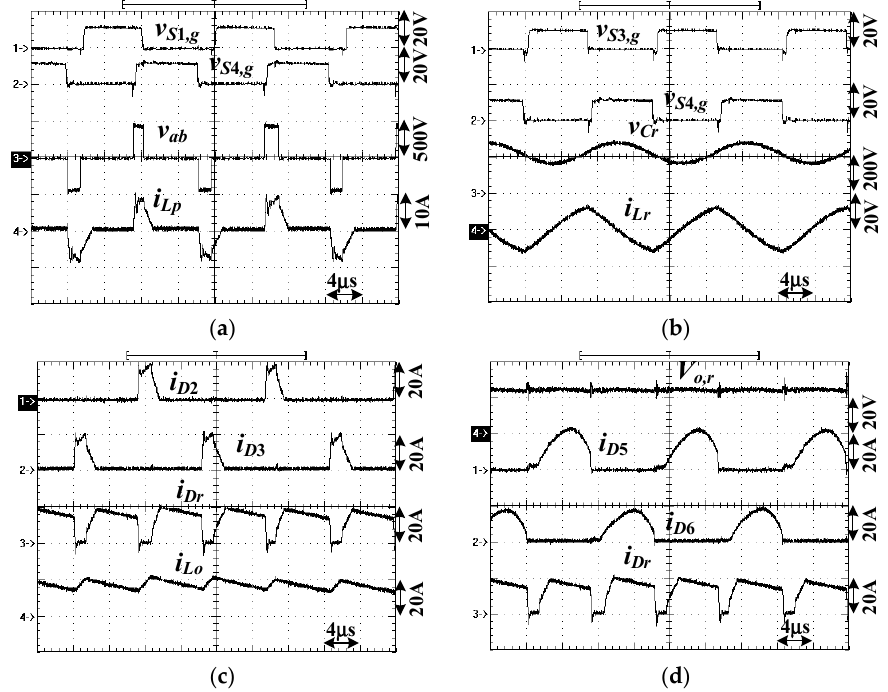
Figure 9. Measured results at V in = 450 V and full load under high voltage input region ( a ) v S 1 ,g , v S 4 ,g , v ab , and i Lp ( b ) v S 3 ,g , v S 4 ,g , v Cr , and i Lr ( c ) i D 2 , i D 3 , i Dr , and i Lo ( d ) i D 5 , i D 6 , i Dr , and V o,r .